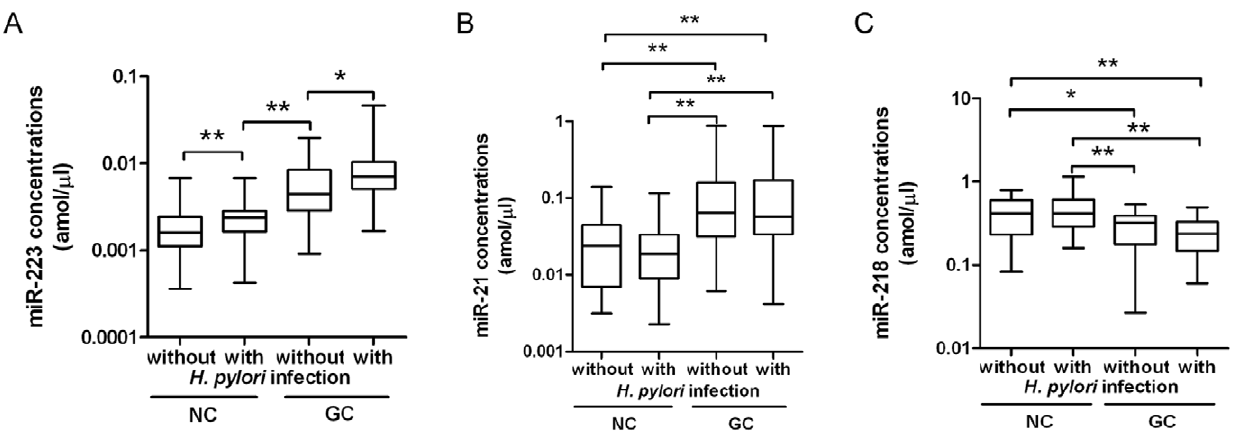
Figure 5. Analyses of the plasma concentrations of miR-223, miR-21 and miR-218 in subjects with H. pylori infection and those without. Box plots of the plasma concentrations of miR-223, miR-21 and miR-218 in GC patients with H. pylori infection (With, n=43) and those without (Without, n=27), and in healthy control subjects with H. pylori infection (With, n=31) and those without (Without, n=39). Note: *, P , 0.05; **, P , 0.01. Box plots show the plasma levels of miR-223 (A), miR-21 (B) and miR-218 (C). The lines inside the boxes denote the medians. The whiskers of box plots: Min to Max.